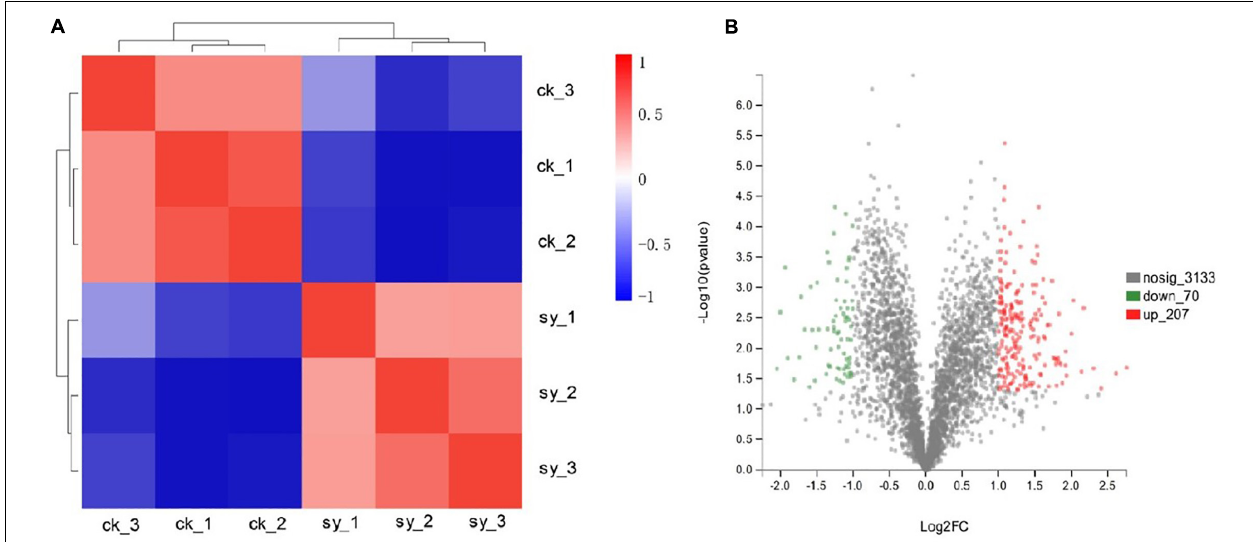
FIGURE 2 | Proteins in P. digitatum cells under 1.2 mg/mL X33 antifungal extract treatment. (A) Expression changes of major DEPs of P. digitatum cells. (B) Cluster analysis of differentially expressed